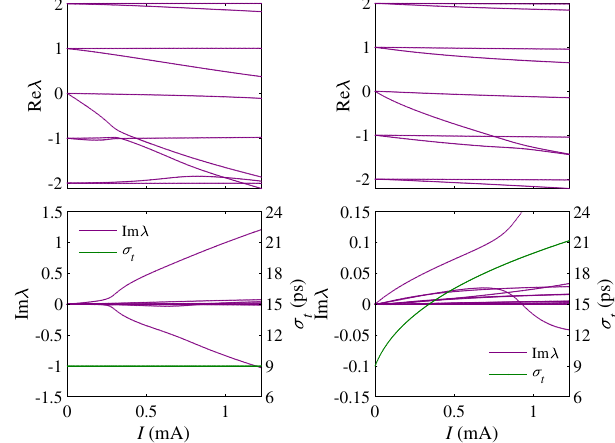
FIG. 3. Effect of bunch lengthening on the frequencies (top) and damping/growth rates (bottom) of the ten lowest vertical